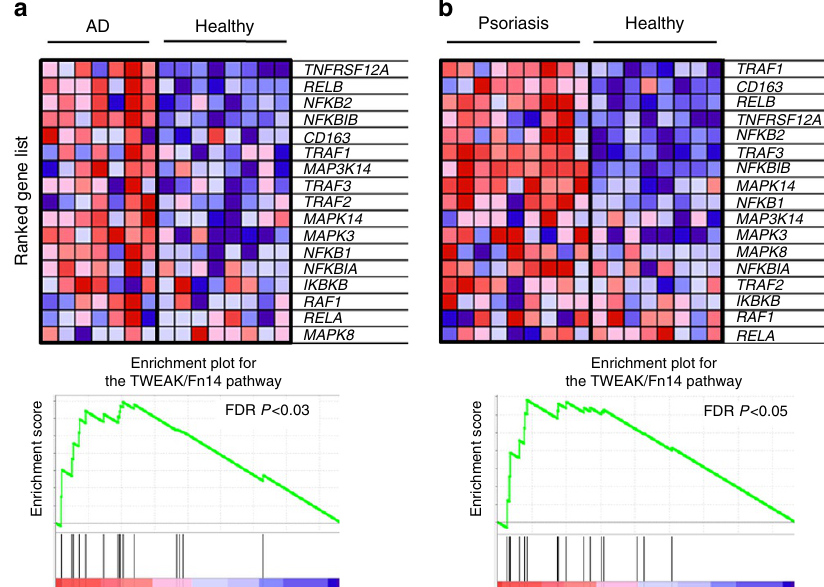
Figure 7 | Gene set enrichment for the TWEAK/Fn14 pathway in AD and psoriasis. Gene set enrichment analysis of skin biopsies from healthy ( n ¼ 8), AD ( n ¼ 7), and psoriasis patients ( n ¼ 9). GenePattern 2.0 (ref. 74) was used to process RNA array data for gene set enrichment analysis 75 which was run with the default settings (100 iterations, weighted). A FDR P value o 0.05 was considered significant. Fn14 (TNFRSF12A) and intracellular signalling and effector molecules are significantly enriched among the induced transcripts from AD ( a ) and psoriasis lesions ( b ) when compared to healthy control specimens (FDR P o 0.05 in both comparisons). FDR, false discovery skin specimens from AD and psoriasis patients 45 and confirmed that Fn14 and a number of signalling molecules associated with its activity are strongly increased in lesions of both diseases when compared to specimens from healthy controls (Fig. 7). Collectively, the data support a role for the TWEAK/Fn14 axis in the pathogenesis of these human disorders.